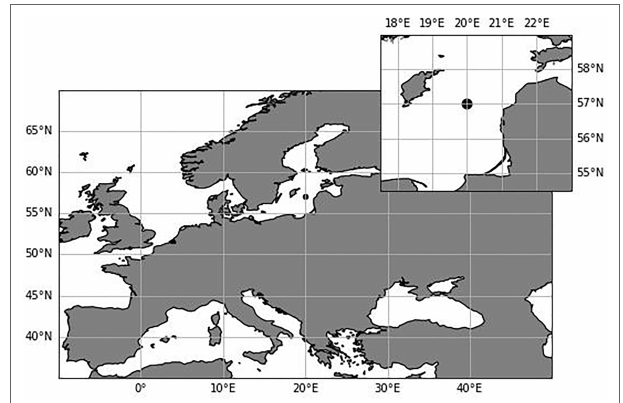
FIGURE 1 | Location of the monitoring station TF271 (black dot) in the Gotland Basin, Baltic